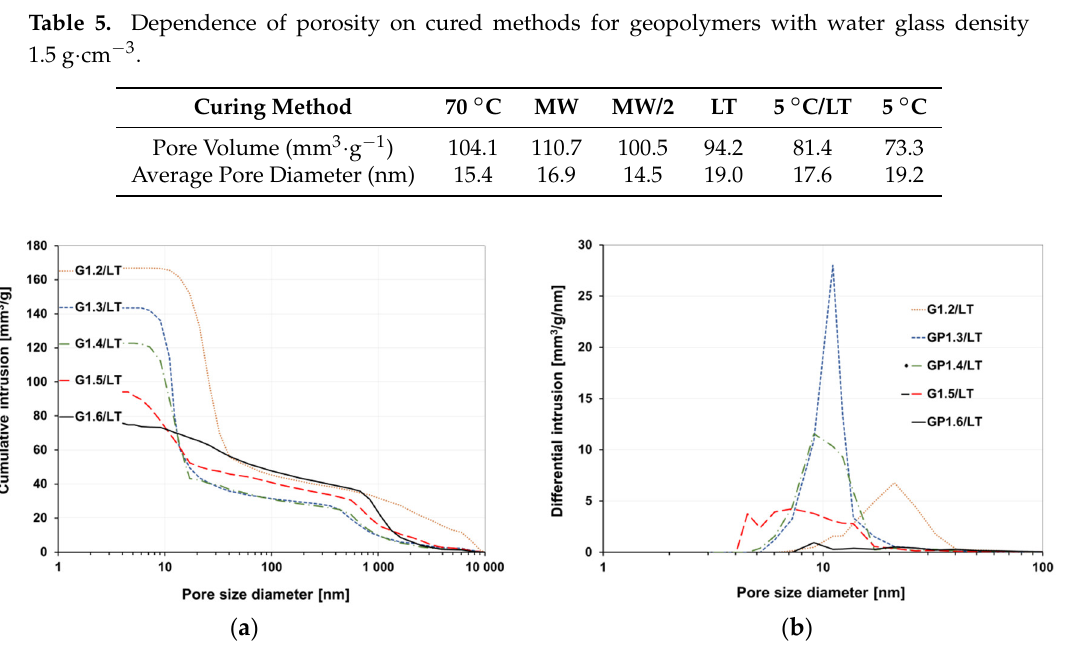
Figure 6. Cumulative ( a ) and differential ( b ) pore volumes for geopolymers made from water glass with different density cured at the ambient temperature.